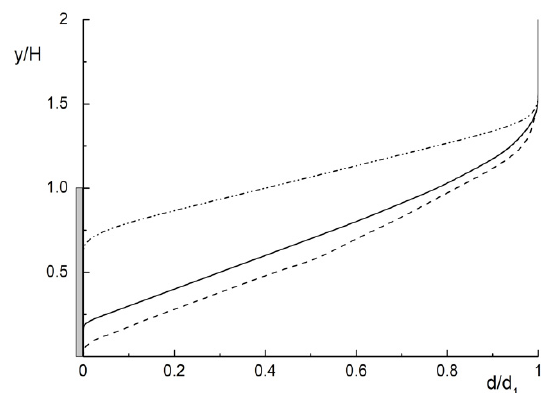
Figure 5. The transverse profiles of normalized droplets diameter in the mist backward-facing step flow. x / H = 2, M L 1 = 0.05. Legends to the figure are the same as in Figure 4.